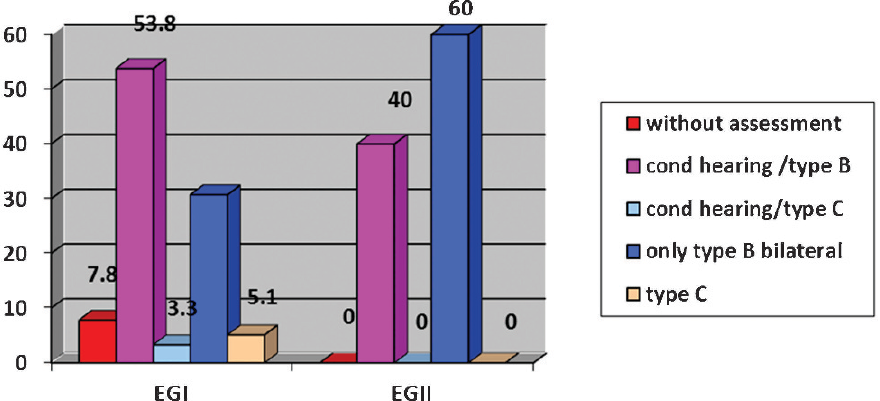
Figure 1 - Percentage of presurgical hearing evaluations performed on students from EGI and